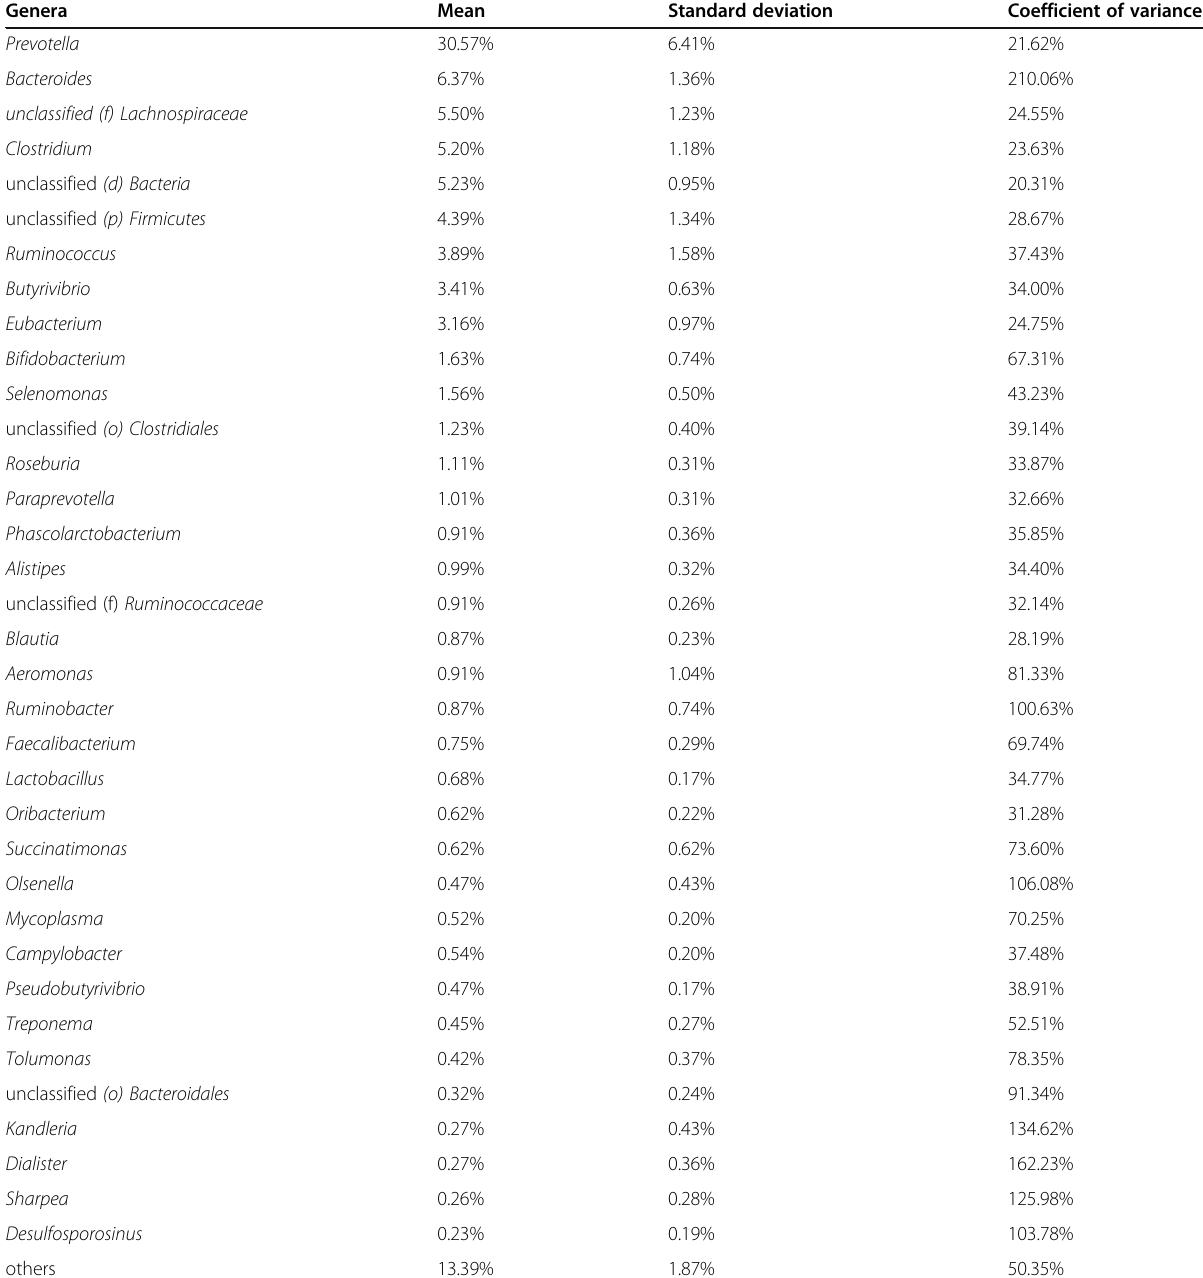
Table 1 Relative abundances of predominant ARG-predicted bacterial genera Genera Mean Standard deviation Coefficient of